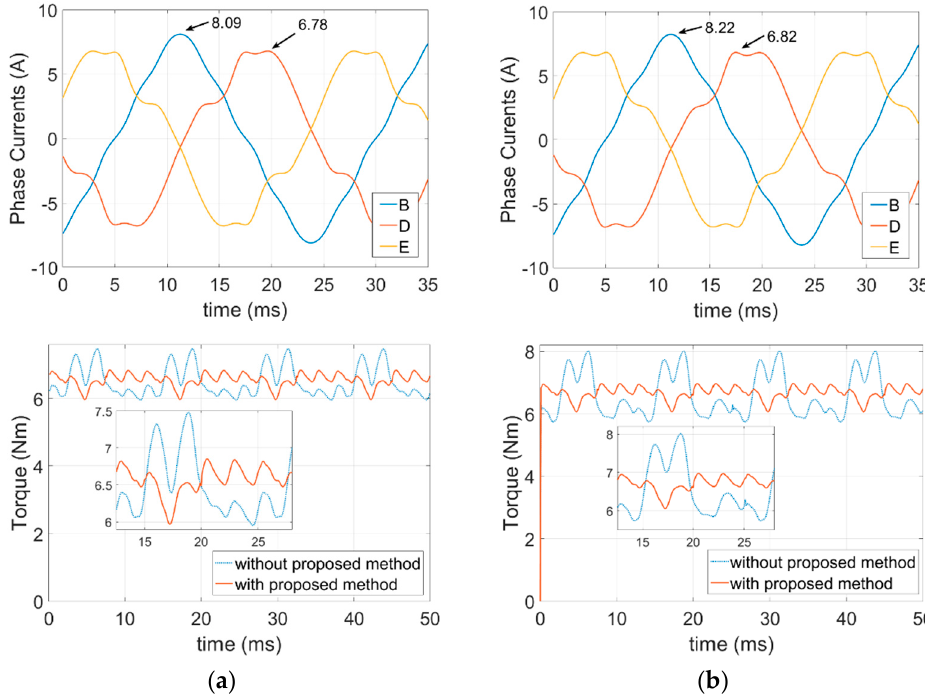
Figure 14. FEA torque waveforms for the fault-tolerant control currents of the NADPOC condition with and without the proposed method: ( a ) Only fundamental; ( b ) fundamental plus third harmonic.